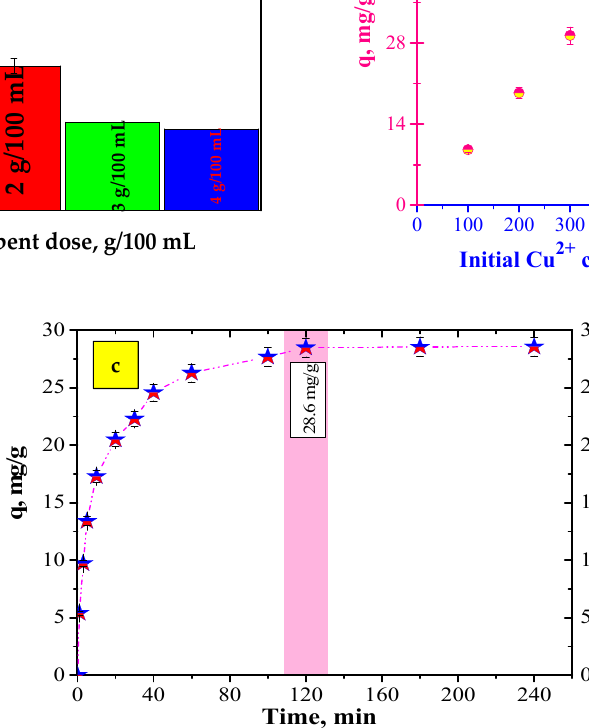
°C); ( b ) Influence of initial concentration (pH, 5.0; contact time, 24 h; adsorbent dose, 1 g/100 mL; temperature, 25 °C); ( c ) temperature, 25 ◦